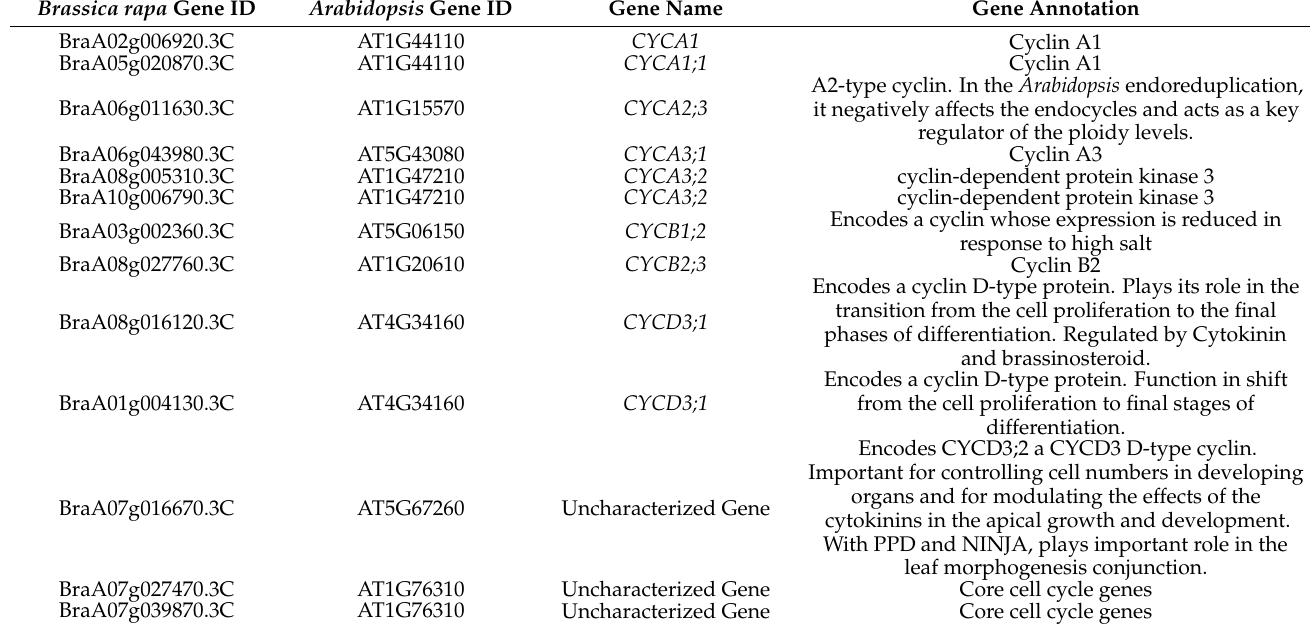
Table 3. Gene annotation of the differentially expressed cyclin genes.